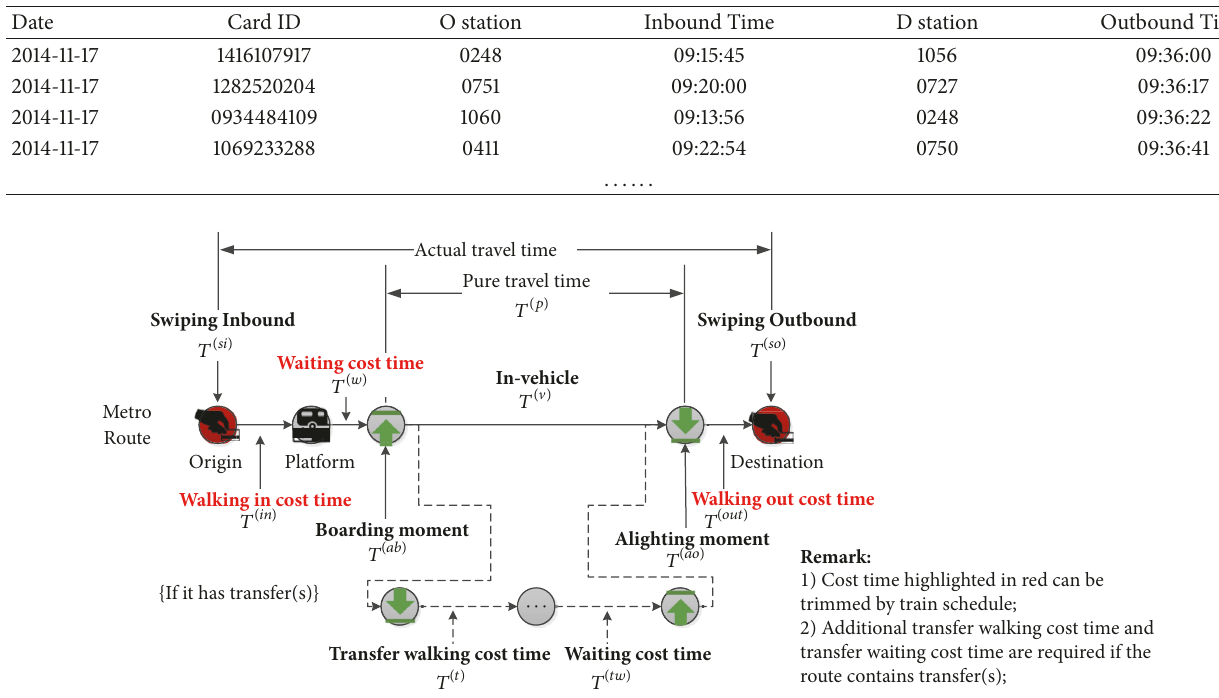
Table 1: Samples of smart card data.